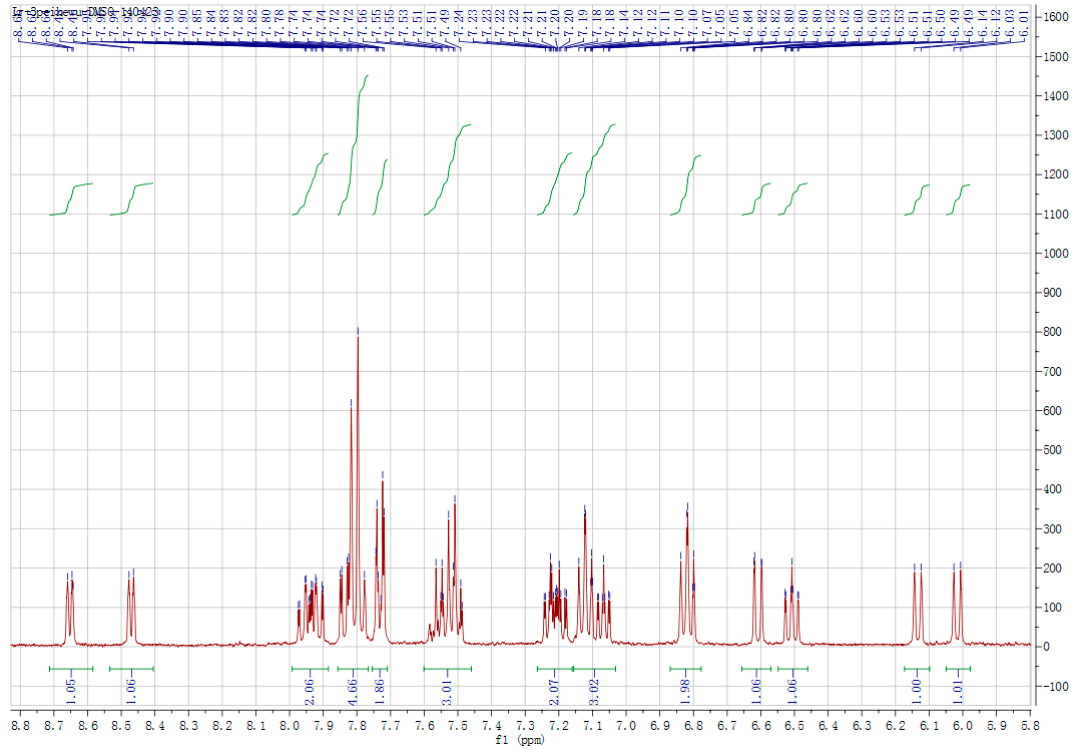
Figure 3. 1 H NMR spectra of coordination compound Ir1.